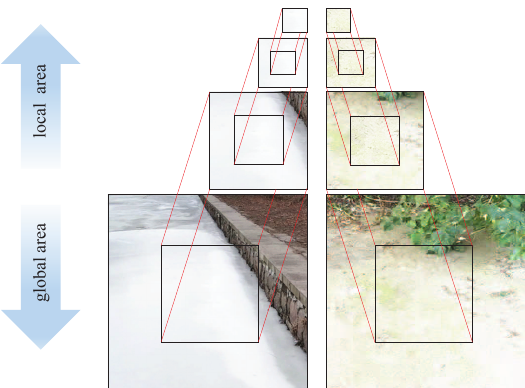
Figure 7. The images at the top show that ice and rock have similar appearances in the local image due to the influence of illumination or other factors. The images at the bottom show that a large perception area has more contextual information. As can be seen from the figure, contextual information is very beneficial for distinguishing types correctly. The red lines indicate the position of the small area in the large area.